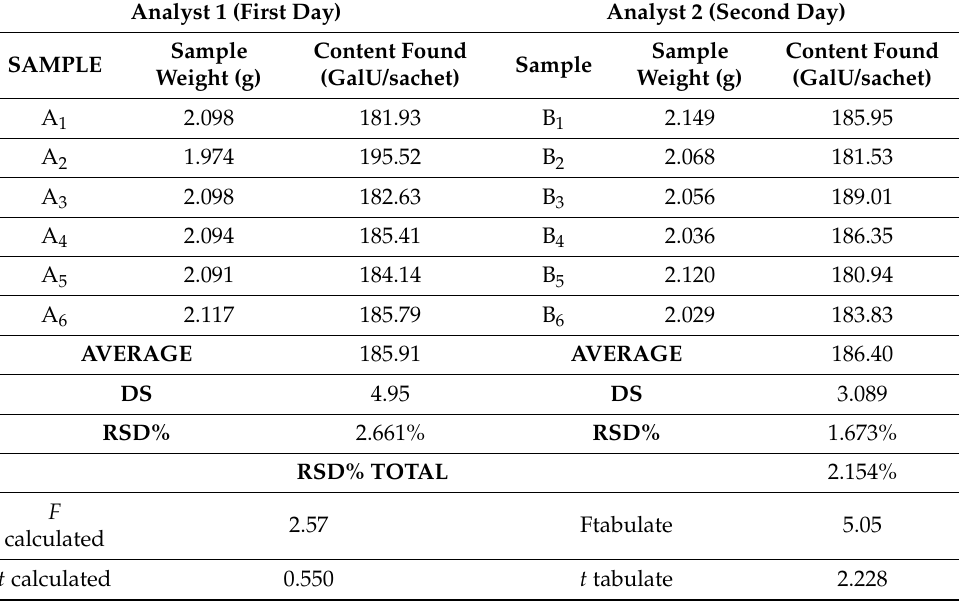
Table 1. The raw data obtained and employed for the determination of method precision and intermediate precision. For each calculation the average, the residual standard deviation (RSD), the calculated Student’s t -value (t), and F-values (F)were computed RSD: Relative Standard Deviation, DS: Standard